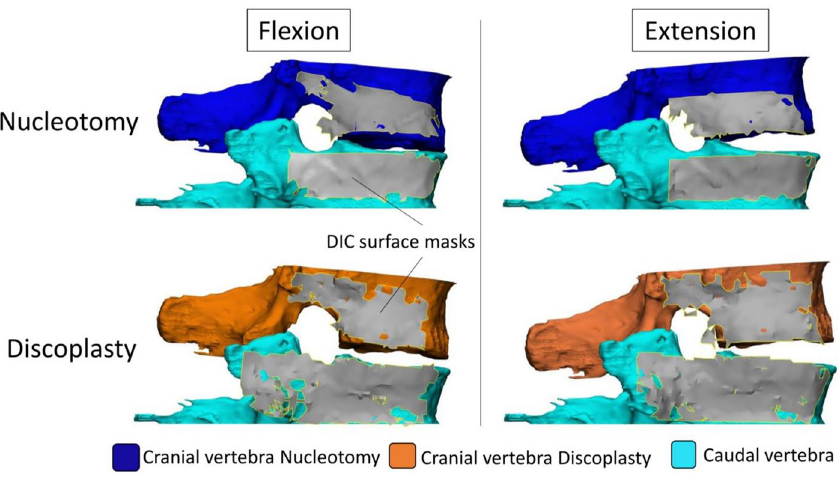
Figure 3. Representative specimen with DIC surface masks (grey) registered for the four test configurations. The complete set of specimens is available from the figshare database (accession number 10.6084/ m9.figshare.19196237).